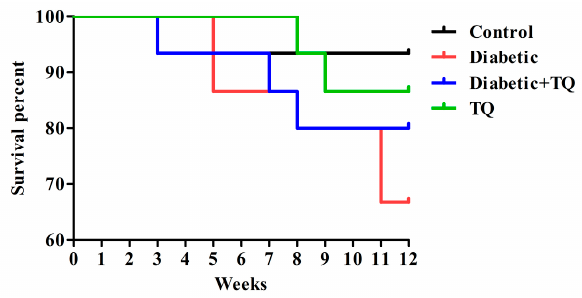
Figure 2. Survival percentages in groups: Control (93.33%), Diabetic (66.67%), Diabetic + TQ (80%), and TQ (86.67%). TQ; thymoquinone.